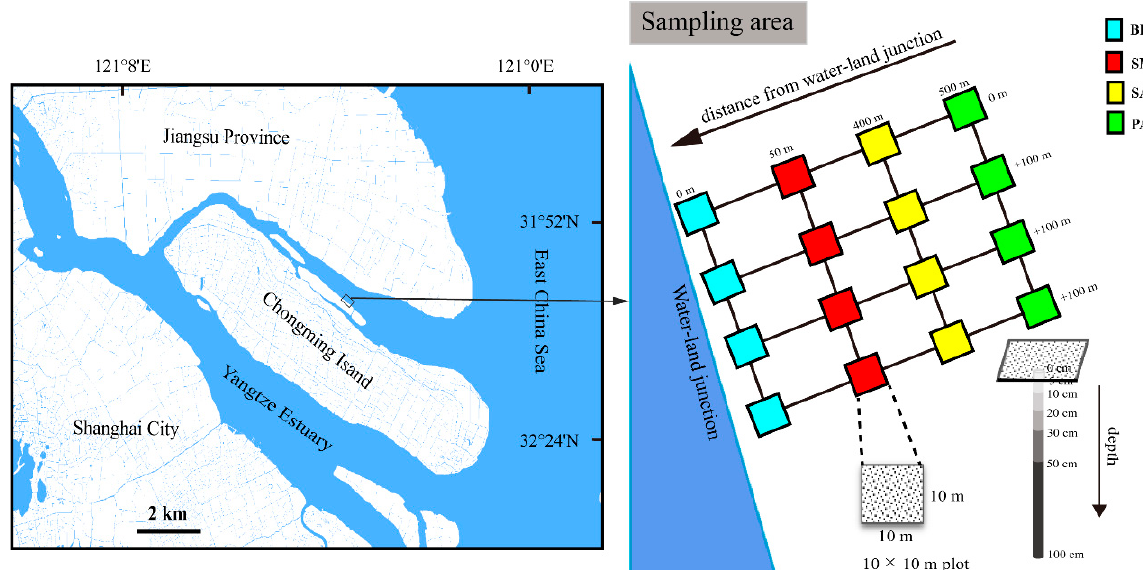
Figure 1. Location of the study area and sampling sites. SM: S. mariqueter; SA: S. alterniflora; PA: P.australis ; BF: bare mudflat.